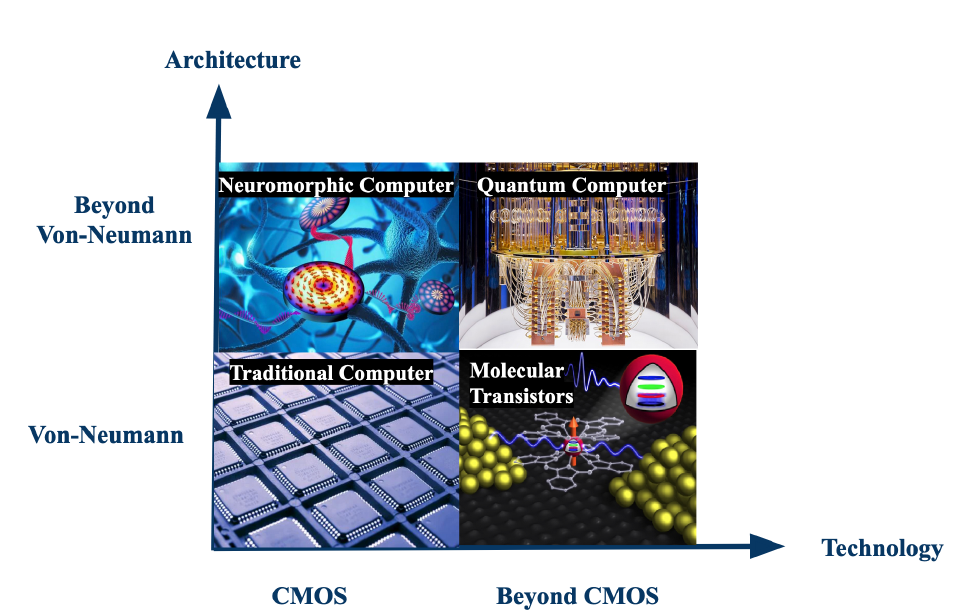
Figure 1. Schematic picture for different paradigms of computing. The vertical axis in- dicates computing technology based on complementary metal-oxide-semiconductor, CMOS (IBM chip) (IBM, n.d.) and non-CMOS technology (a single-molecule transistor can be con- sidered among the smallest possible) (Thiele et al., 2014). The perpendicular axis indicates the architecture of the computing presenting standard von Neumann with distinguishable CPU and memory units, and non–von Neumann architectures such as brain-inspired or neu- romorphic computing (Esser et al., 2016; Körber et al., 2020). Quantum computers can be considered as novel technologies beyond CMOS with non–von Neumann architecture (Ball et al.,